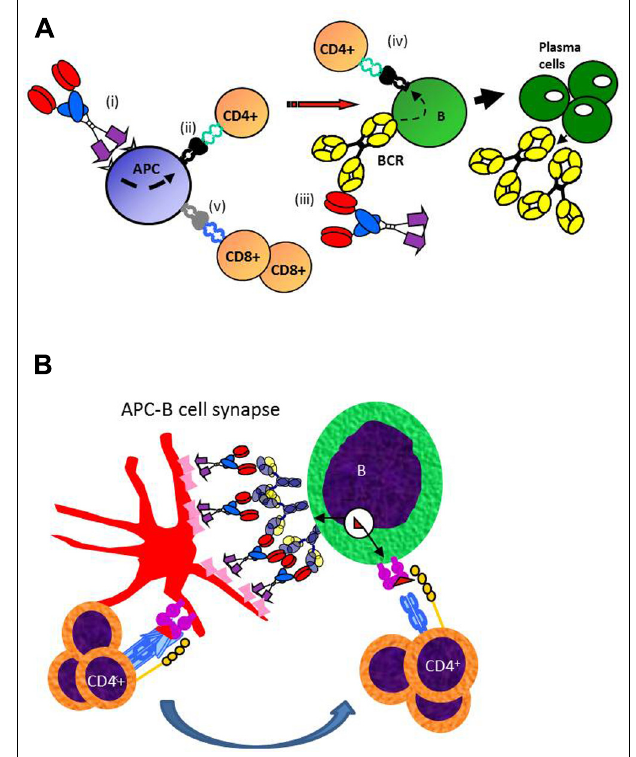
FIGURE 3 | Proposed mechanism for howAPC-targeted homodimeric vaccine molecules efficiently stimulate bothT and B cell responses. (A) (i)Vaccibodies bind to surface molecules on APC, such as dendritic cells and induce their maturation. (ii)Vaccibodies are processed and peptides from the antigenic unit are presented on MHC class II molecules of APC to naïve CD4 + T cells that become effectorT cells. (iii) B cells with a B cell receptor (BCR)-specific for conformational determinants on complete vaccibodies internalize vaccibodies; process them, and present antigenic peptides on their MHC class II molecules to the effector CD4 + T cells. (iv) B cells receive help from the effector CD4 + T cells and develop into plasma cells that secrete antibodies. Finally, antigen-specific antibodies and CD4 + T cells cause the elimination of the antigen. (v)Vaccibodies with certain targeting units (MIP-1 α ) can induce presentation on MHC class I, and cross-priming of CD8 + T cells is thought to be particularly important for viral infections and cancer. (B) A variant model where homodimeric vaccine molecules bridge APC and B cells, resulting in a “tug of war” for antigen.T cell could interact with MHC II-Ag complexes on both APC and B cells, as